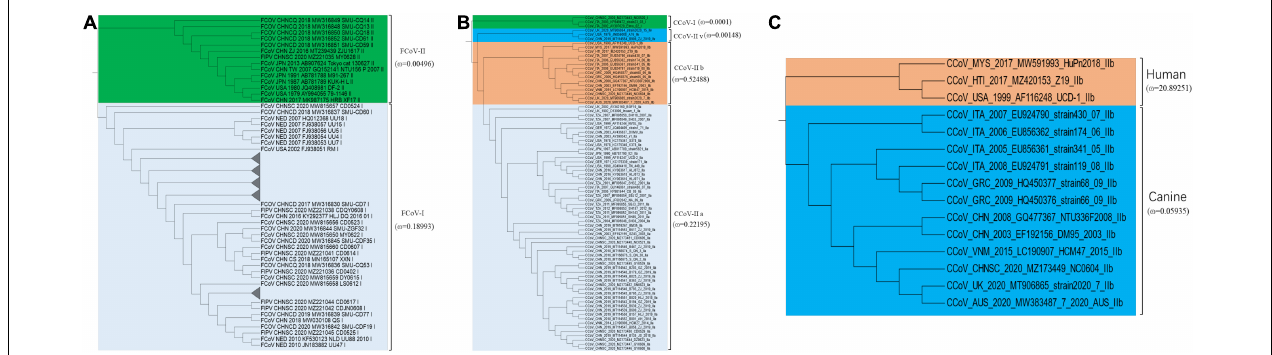
FIGURE 2 | Natural selection analysis of inter-lineage. ω value means the ratio of non-synonymous to synonymous substitution rates (dN/dS). Using the branch model to calculate the selection constraints of different clades in EasyCodeML (version 1.4). (A) Comparison of selection constraints between FCoV-I and FCoV-II. (B) Comparison of selection constraints between CCoV-I, CCoV-IIv, CCoV-IIb, and CCoV-IIa. (C) Comparison of selection constraints between human-derived CCoV and canine-derived CCoV.